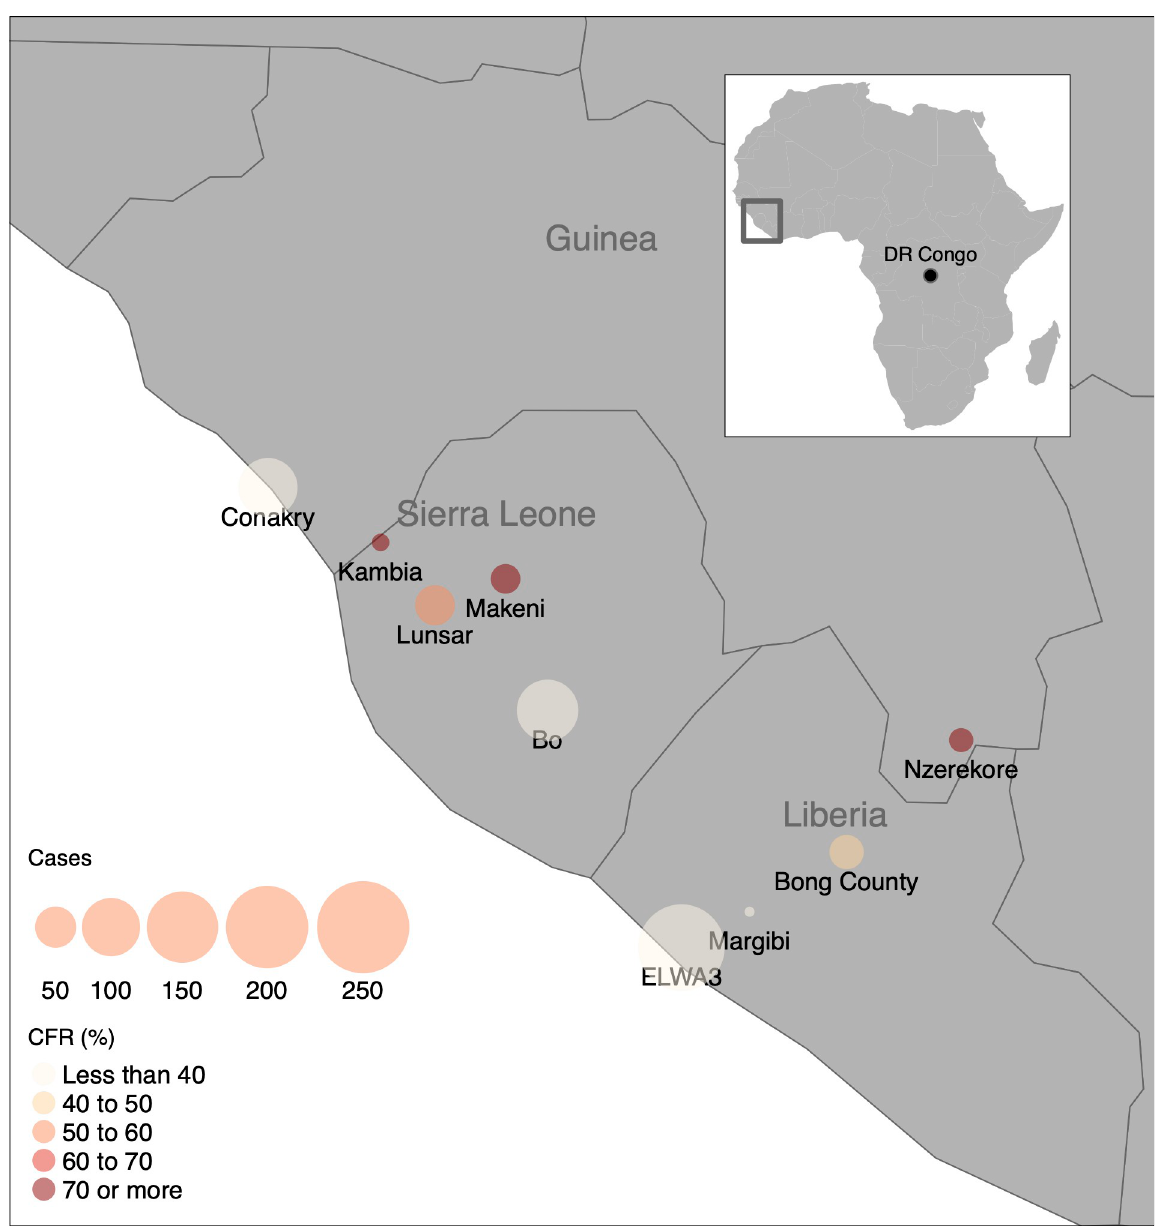
Fig 1. Map of children with Ebola Virus Disease (EVD). The map shows the geographical distribution of children with EVD included in triage data from the Ebola Data Platform, collected during the West African EVD outbreak from 2014–2016. Bubble size corresponds to the number of cases reported, and color corresponds to observed case fatality rate. Plotted with the R package tmap [52], using base layer maps in the public domain from the Natural Earth project